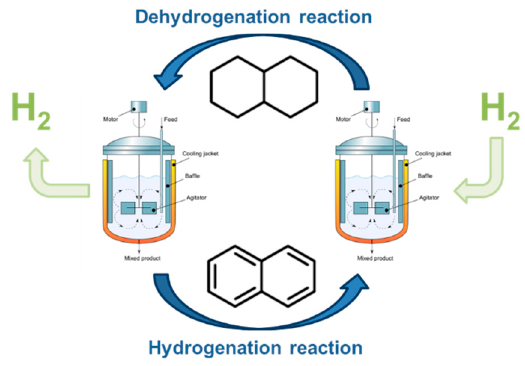
Figure 5. LOHC hydrogenation-dehydrogenation generic process.